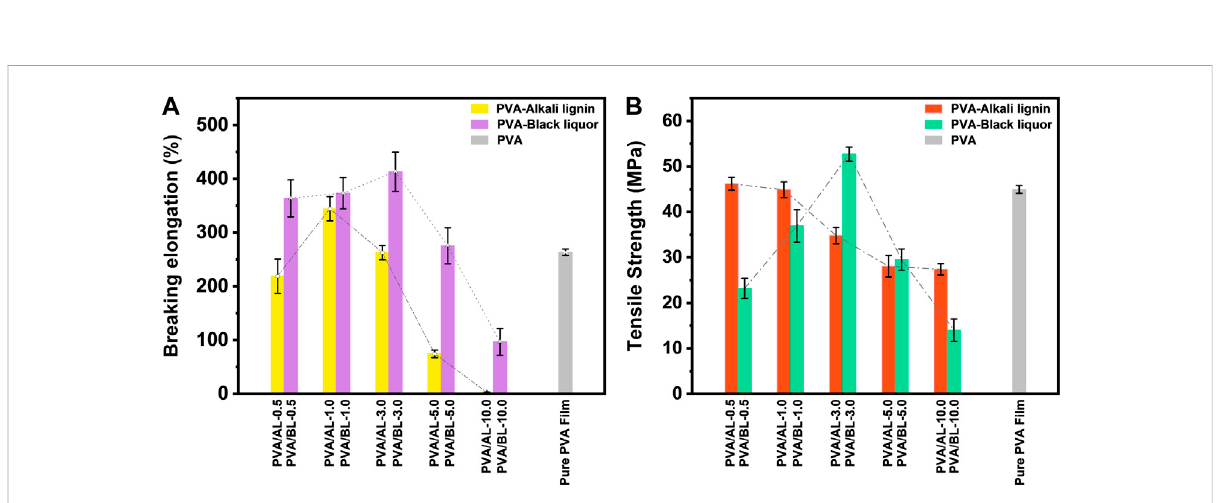
FIGURE 2 Mechanical Properties of various fi lms. (A) breaking elongation of various composite fi lms; (B) tensile strength of various composite fi